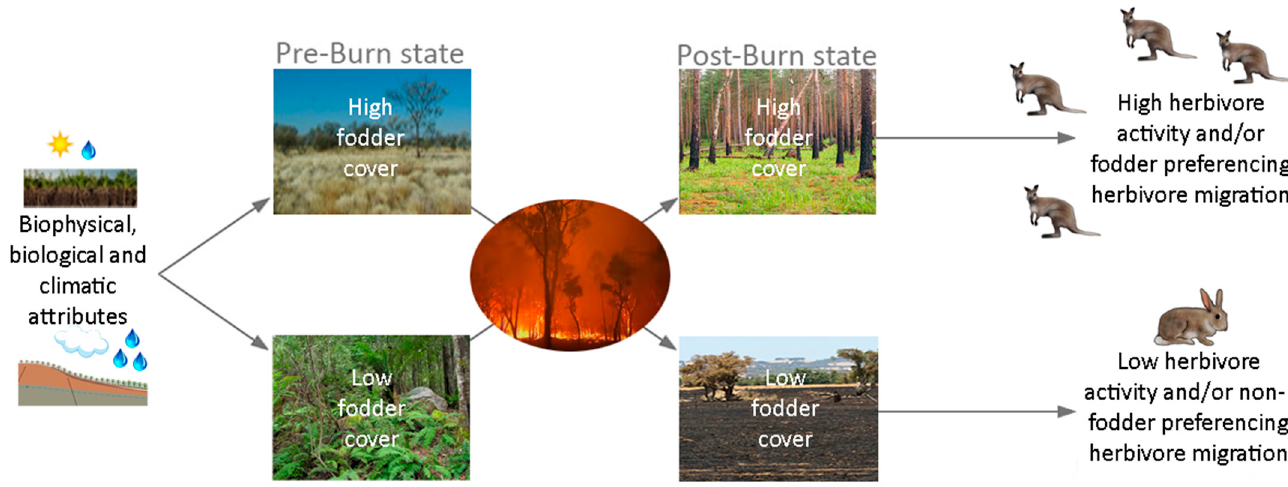
Figure 1. In each ecosystem, the relative abundance of fodder before and after a fire event are hypothesised to have different effects on local vertebrate herbivore activity in association with different herbivore preferences. This means that both the pre- and post-burn predictors of fodder cover are just as important to the final post-burn outcome for herbivores as the food preferences of the herbivores themselves.